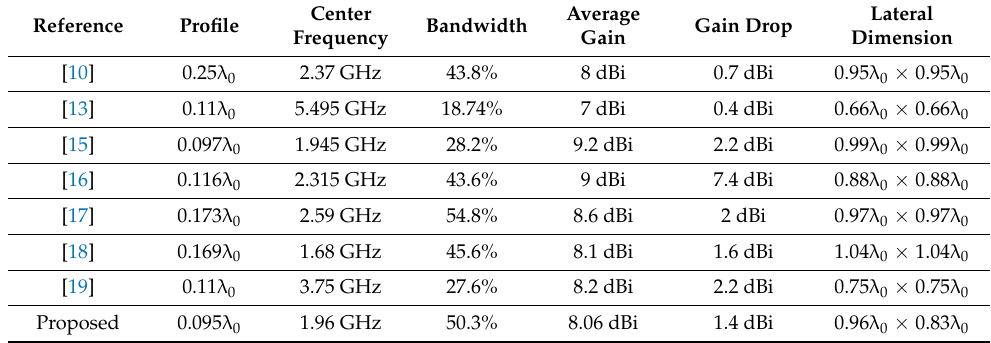
Table 2. The performance comparison between the proposed antenna and other ME